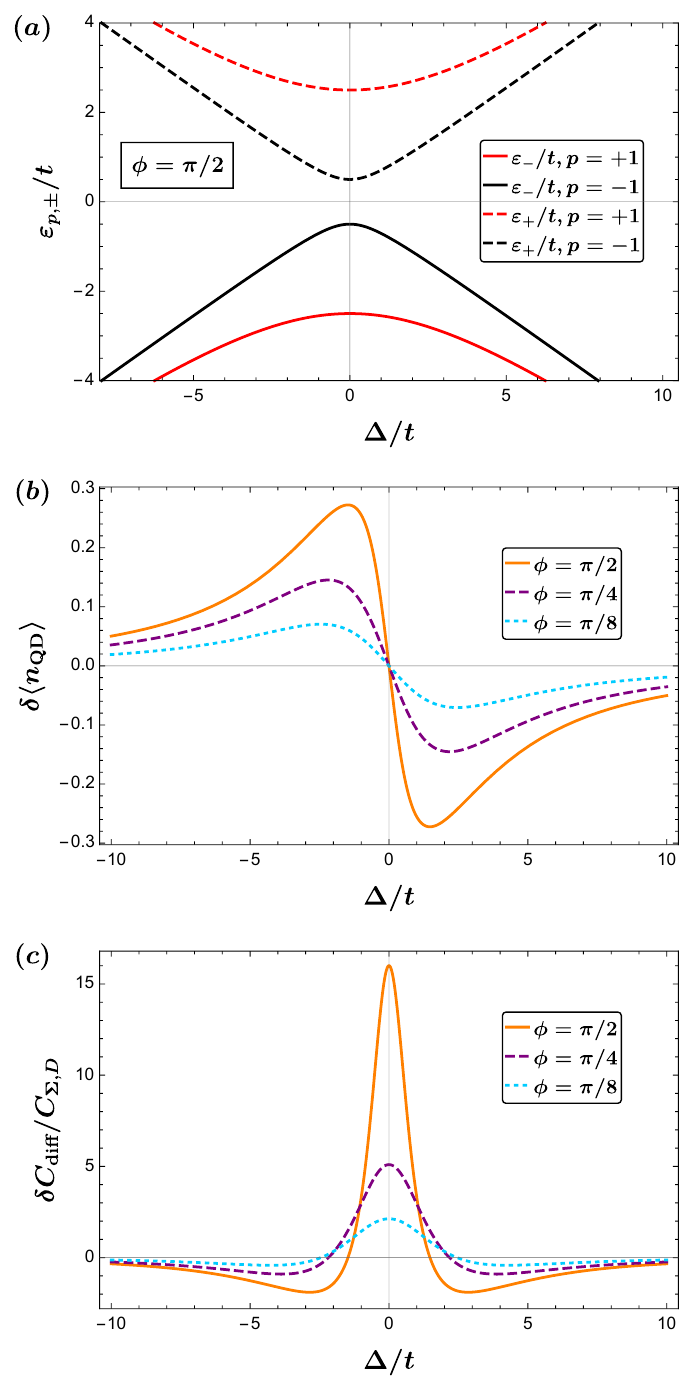
Figure 2: (a) MZM parity dependent part of the energies of the two lowest QD- MZM levels (6) as a function of island-QD detuning ∆ in units of the MZM- QD hopping t . (b) Average QD charge difference between the two parity states δ 〈 n 〉 = 〈 n 〉 − 〈 n 〉 as a function of detuning. (c) Differential capac- QD QD, p =+ 1 QD, p = − 1 itance difference between the two parity states δ C | = t , | t | = 1.5 t for (a)-(c) and C detuning. We set | t 1 2